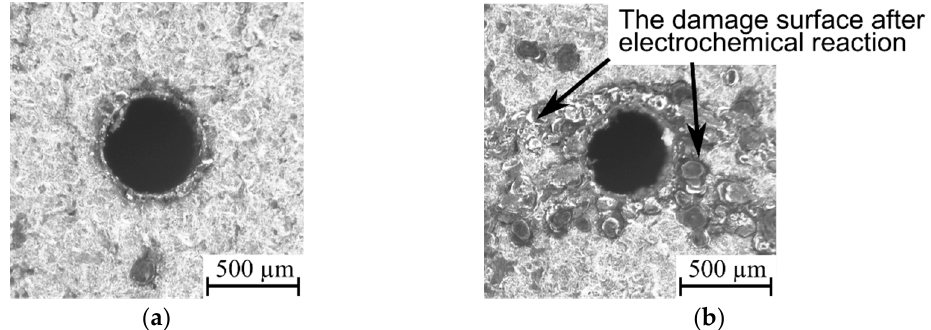
Figure 15. The entrance diameter of a micro-hole fabricated by the pulse time duration: ( a ) t on = 325 µs and I = 3.99 A, U = 100 V, p = 8 MPa, n = 400 rpm; ( b ) t on = 775 µs and I = 3.99 A, U = 100 V, p = 8 MPa, n = 400 rpm.